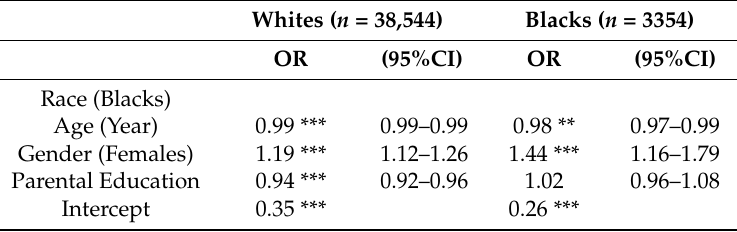
Table 4. Summary of two logistic regression models specific to